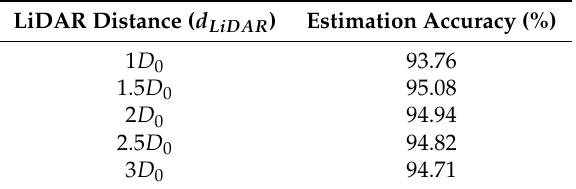
Figure 2. Block diagram representation for wake center estimation. Table 1. Estimationaccuracies for multi-model transfer function